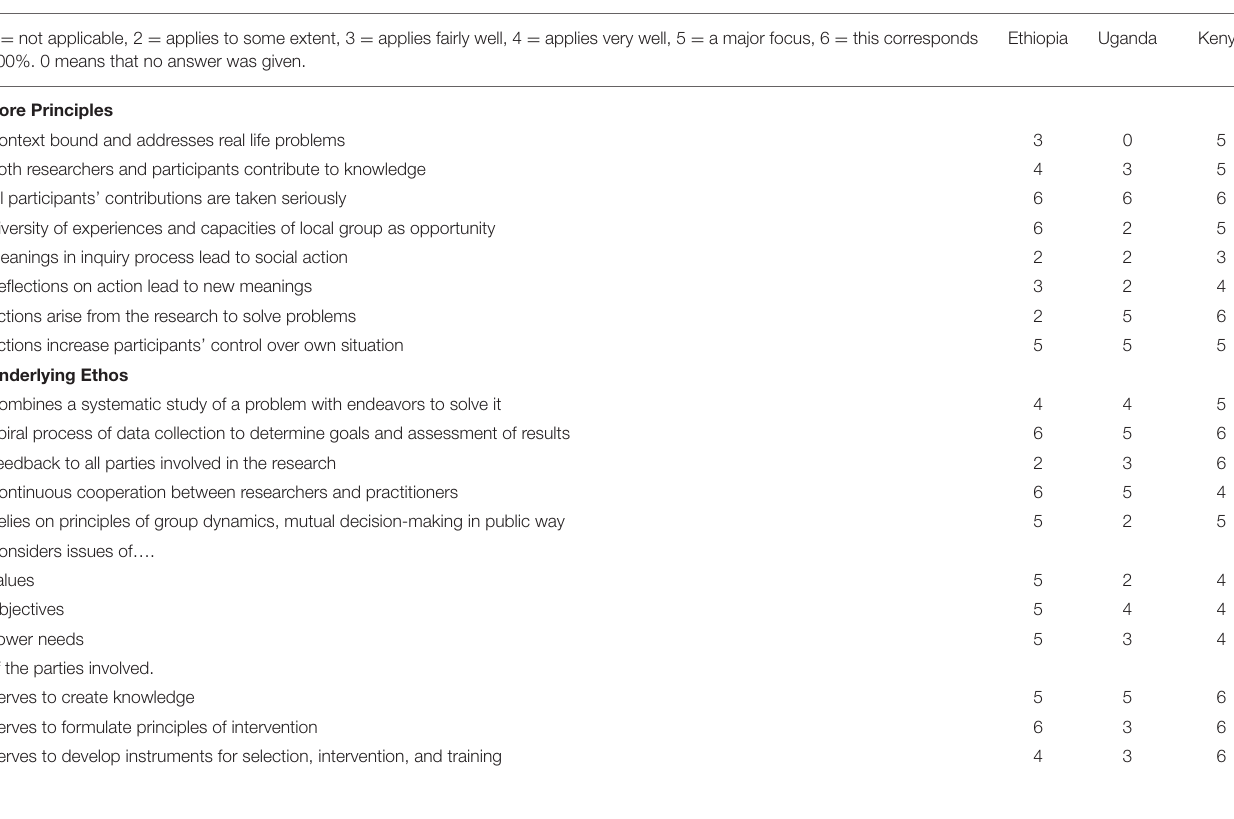
Ethiopia Uganda